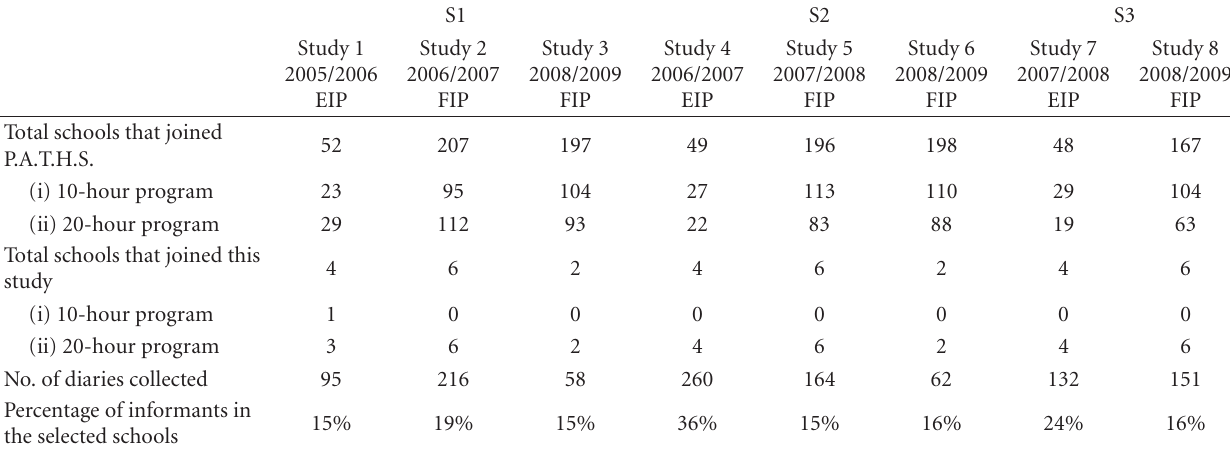
Table 1: Number of respondents writing weekly